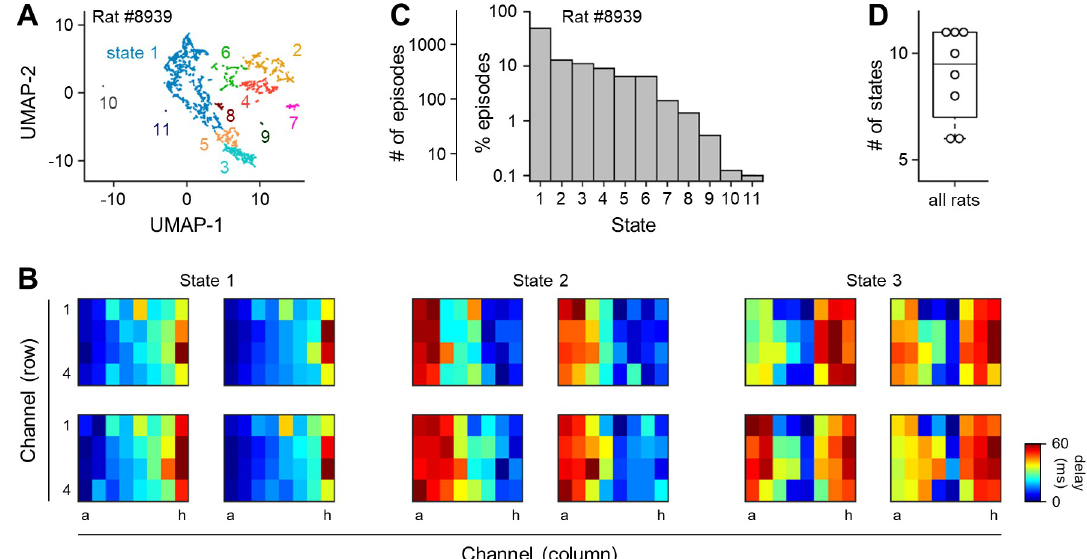
Fig 2. Diversity in the propagation patterns of neural activity in the visual cortices. A , A representative map of ECoG episodes. Each of them was embedded in a two-dimensional UMAP space. All episodes were grouped by the RCC routines to identify states. B , Representative delay matrices for states 1 ( left ), 2 ( middle ), and 3 ( right ) shown in A . C , The percentage and the number of episodes classified into a given state shown in A . D , The number of states of propagation patterns for all rats tested in this study. Abbreviations : UMAP, uniform manifold approximation and projection; RCC, robust continuous